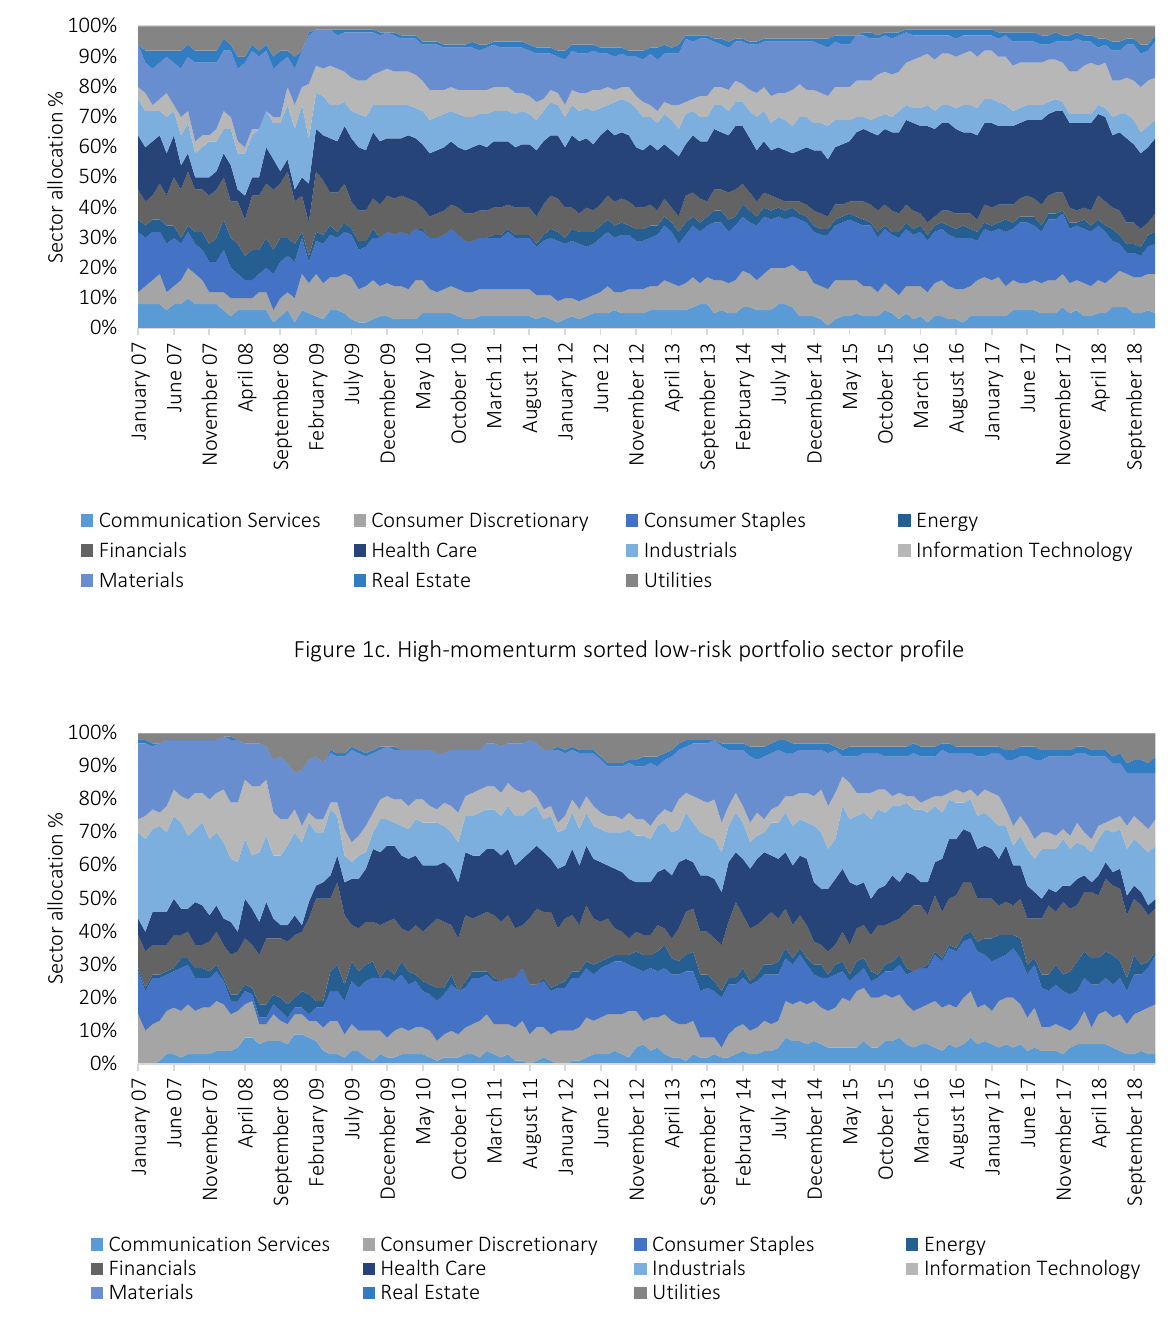
Figure 1. Time-varying sector exposure of long-only low-risk portfolios